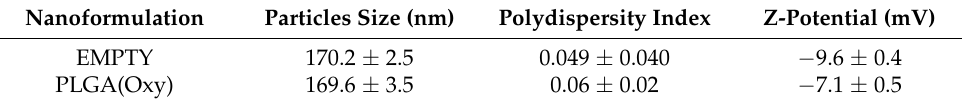
Table 1. Dynamic light scattering and ζ -potential data of unloaded (EMPTY) and oxyresveratrol- loaded (PLGA(oxy)) poly(lactic-co-glycolic acid) (PLGA) nanoparticles. The results are expressed as the mean value ± SD of three independent measures on three replica